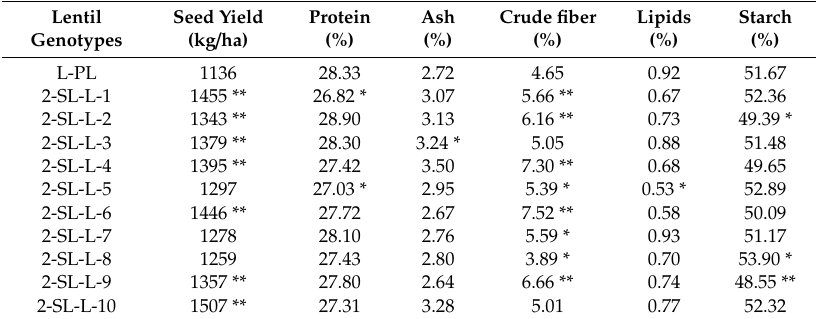
Table 3. Seed yield and nutritional quality traits of the parental landrace “Lefkada” (L-PL) and second-generation sister lines originating from “Lefkada”.